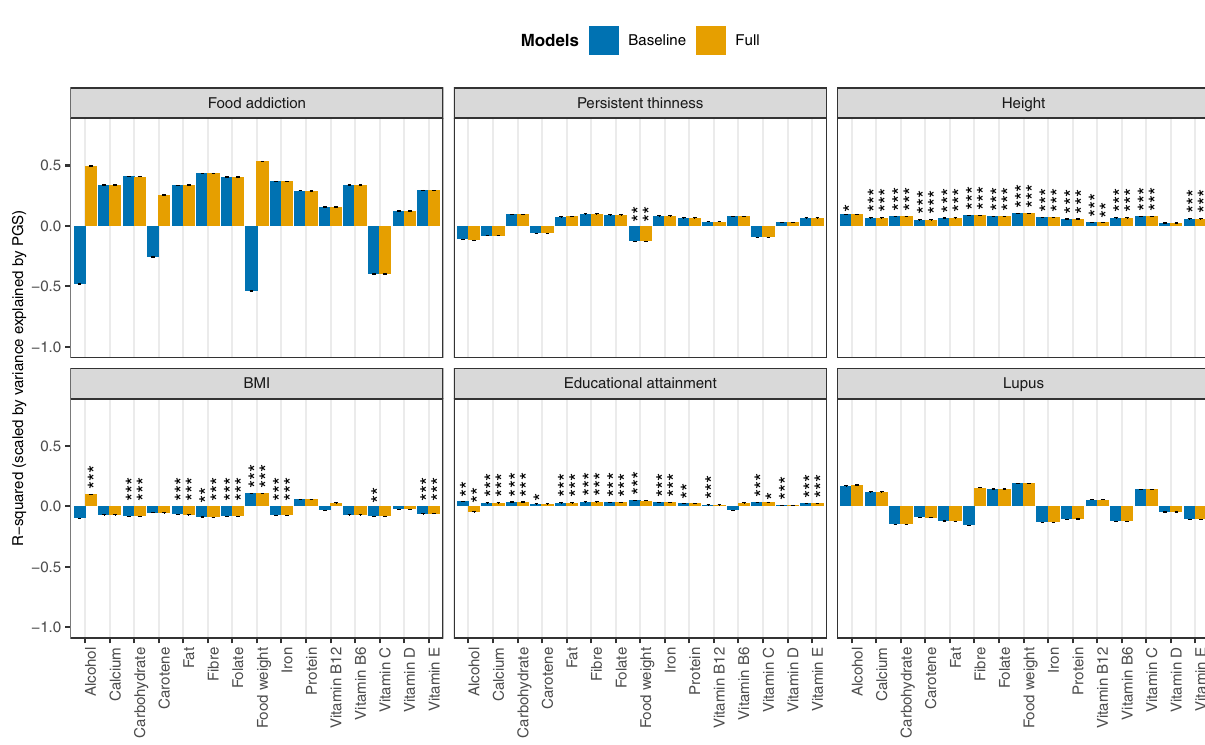
Fig. 2 Associations between polygenic scores for psychiatric, behavioural, and anthropometric traits and nutrient intake. Results are shown from linear mixed-effects model analyses. Y- axis shows the R 2 estimates which have been scaled by the variance explained by the polygenic score predicting itself on the liability scale and have been multiplied by the direction of the coef fi cient estimate. Colours represent the different models: grey for Model 0 (i.e., baseline model) and yellow for Model 5 (i.e., full model) in con fi guration 1. Error bars represent standard errors and asterisks indicate statistically signi fi cant estimates. Bonferroni-corrected p- value thresholds: ∗ = p < 0.05/132, ∗∗ = p < 0.01/132, ∗∗∗ = p < 0.001/132. Data are represented for 163,619 participants of the UK Biobank cohort. The full results can be found in Supplementary Figs. 3 and